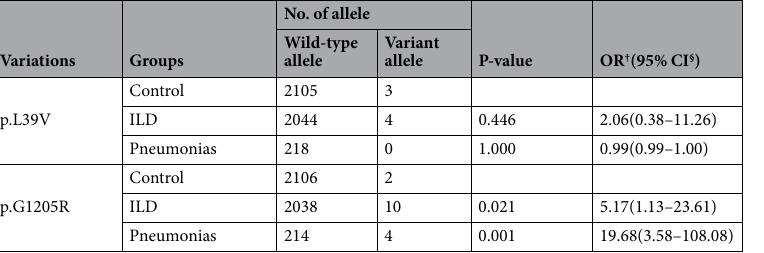
Table 5. Comparisons of allele frequencies on the variants p.L39V and p.G1205R in ABCA3 between ILD patients and healthy controls # . † odds ratio; § 95% confidence interval; # Bonferroni correction was used to adjust the significance level to